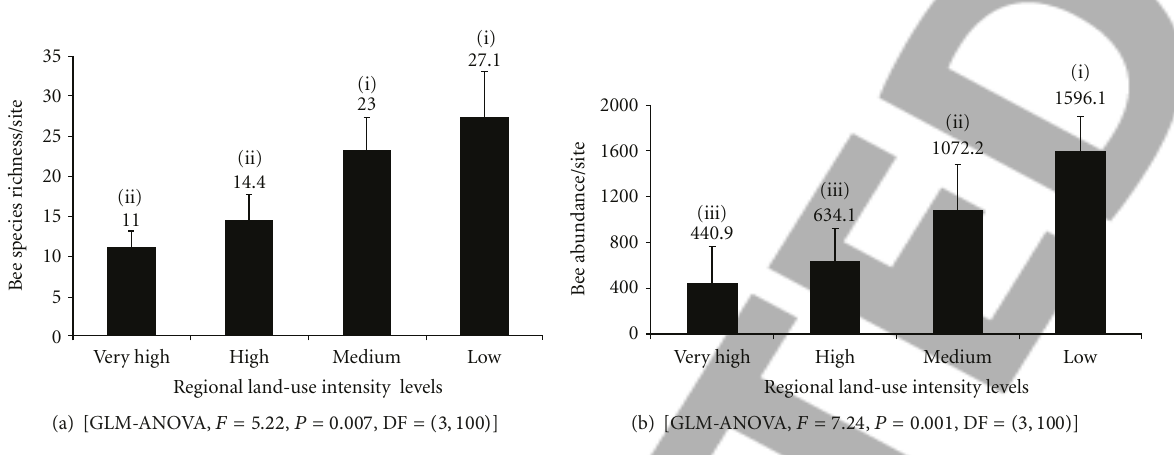
Figure 5: Effects of regional land-use intensity on the species richness (a) and abundances (b) of bees recorded per study site in farmlands of central Uganda. Error bars are ± SE. Means ( 𝑥 ± se) followed by different letters are significantly different at 𝑃 < 0.05 according to Tukey